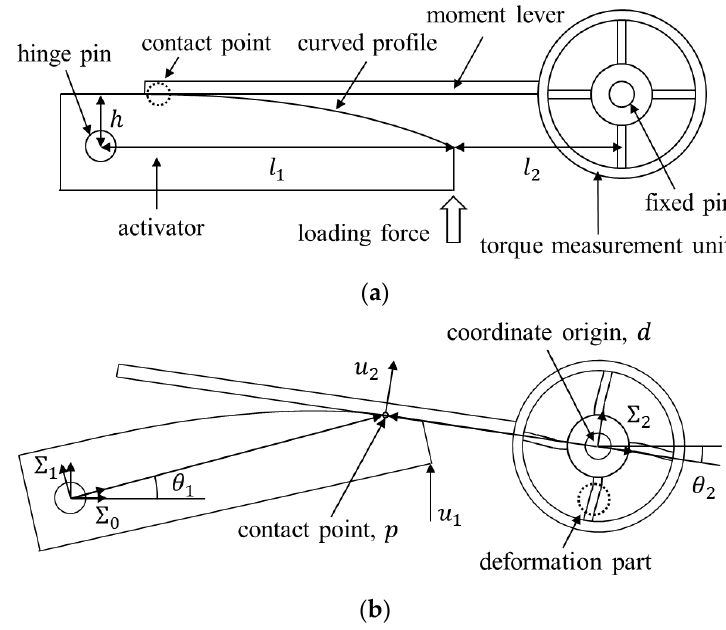
Figure 1. Proposed nonlinear load cell. ( a ) Initial configuration of the mechanical parts. ( b ) Deformation configuration of the activator and the measurement unit according to the loading force.